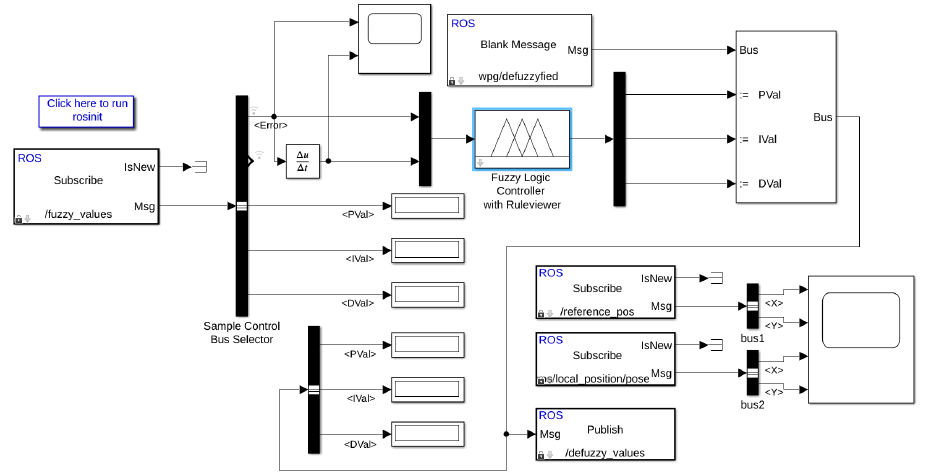
Figure 4. Simulink model for the fuzzy